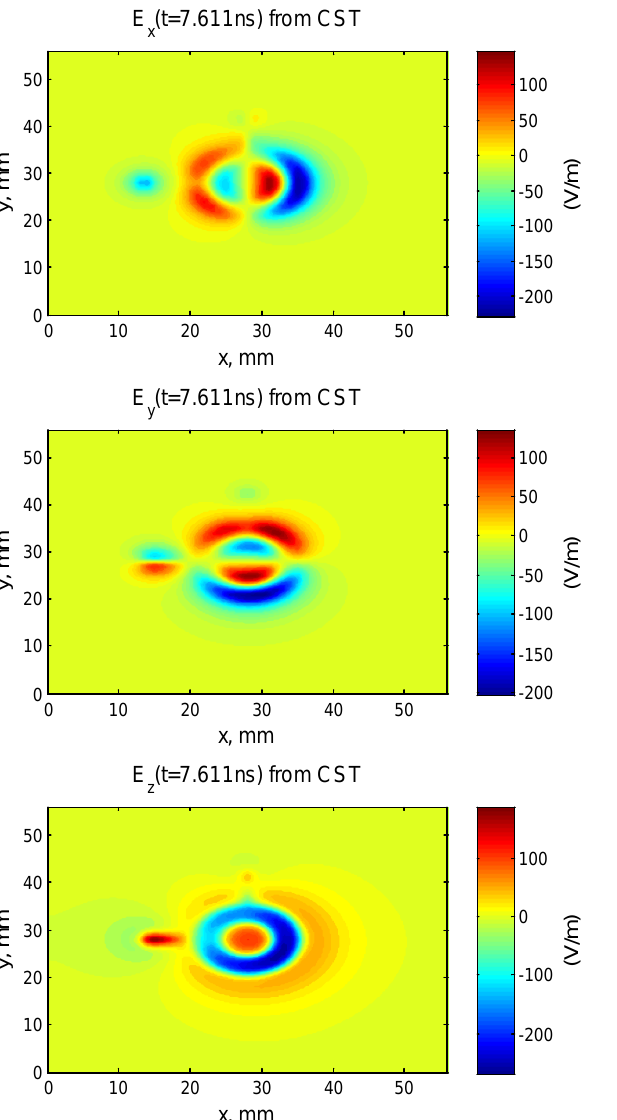
Figure 8 : C artographies o f e lectric f ield components at t =7.611ns obtained from the CST simulation.